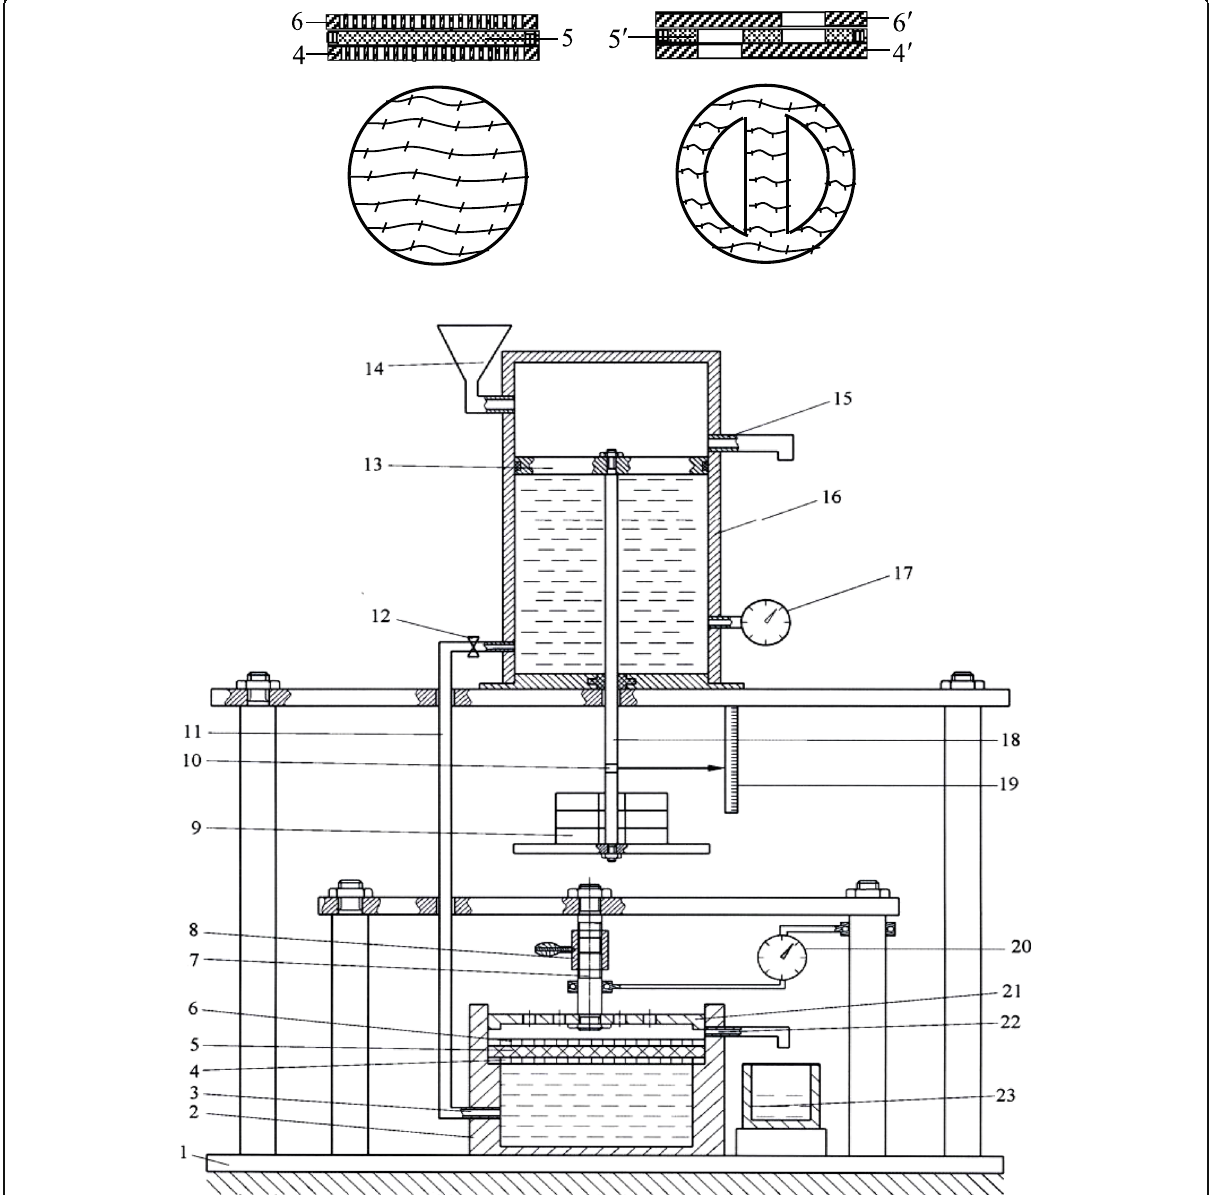
Fig. 3 Installation to test the leather semi-finished product